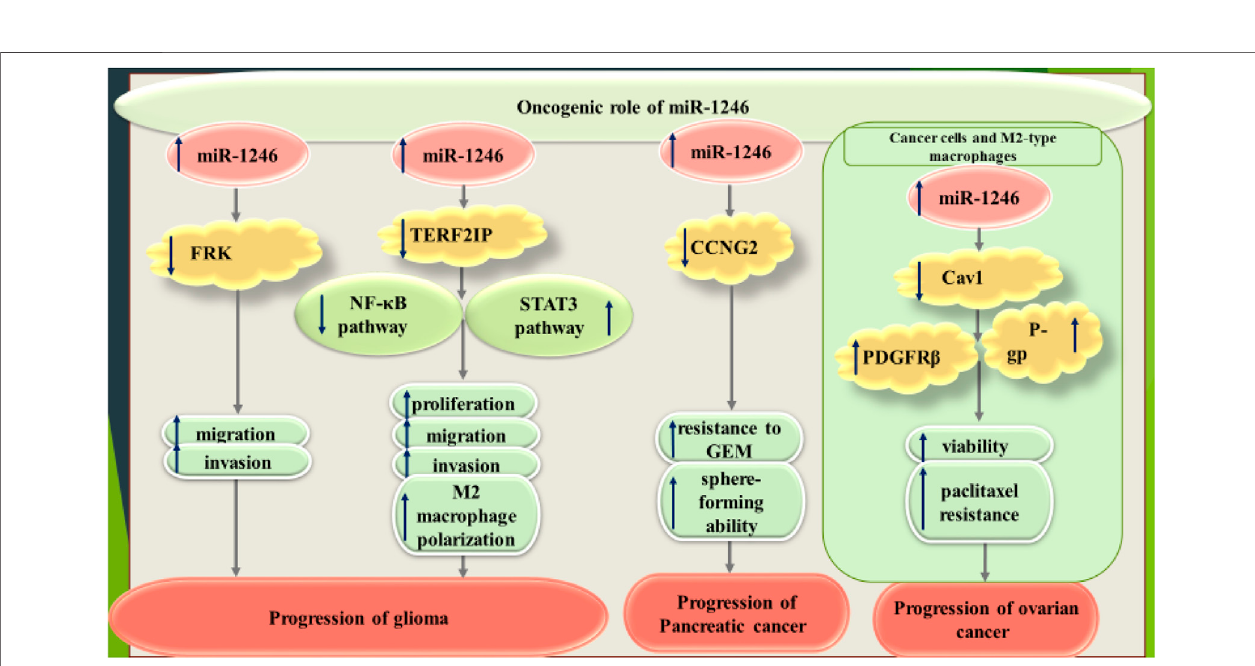
FIGURE 6 | Oncogenic role of miR-1246 in glioma, pancreatic cancer and ovarian cancer.